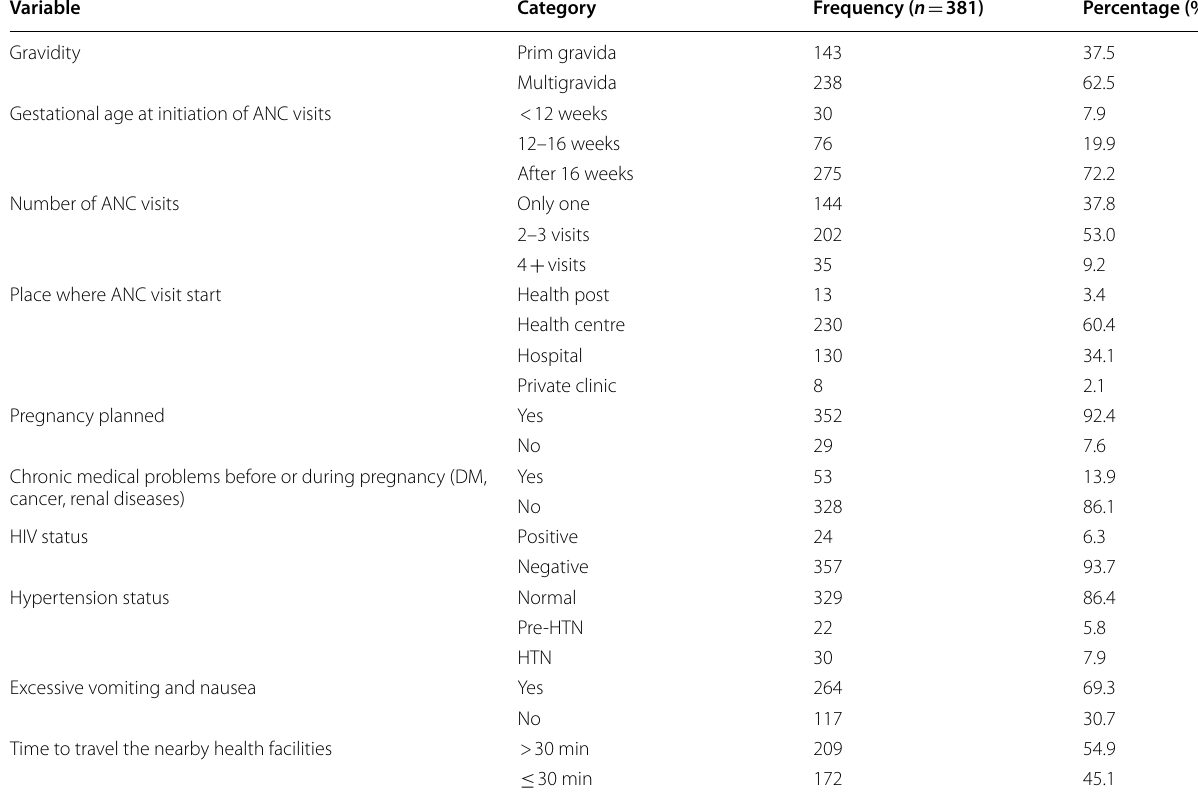
Table 2 Obstetric and medical conditions of pregnant women in the Afar region, northeast Ethiopia Variable